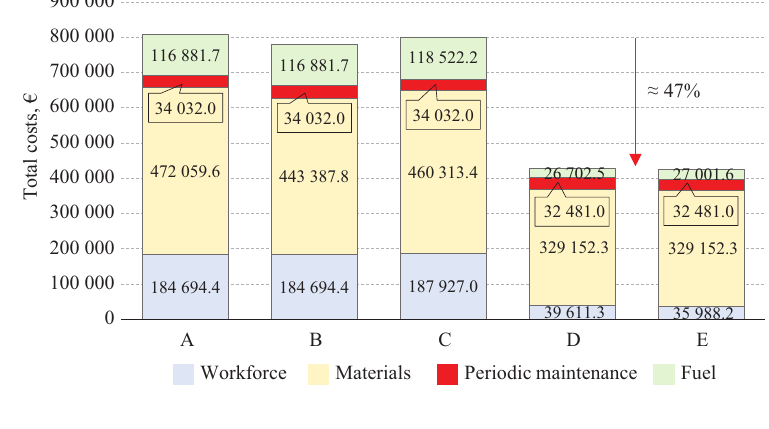
Figure 3. Results of Life Cycle Cost Analysis deterministic